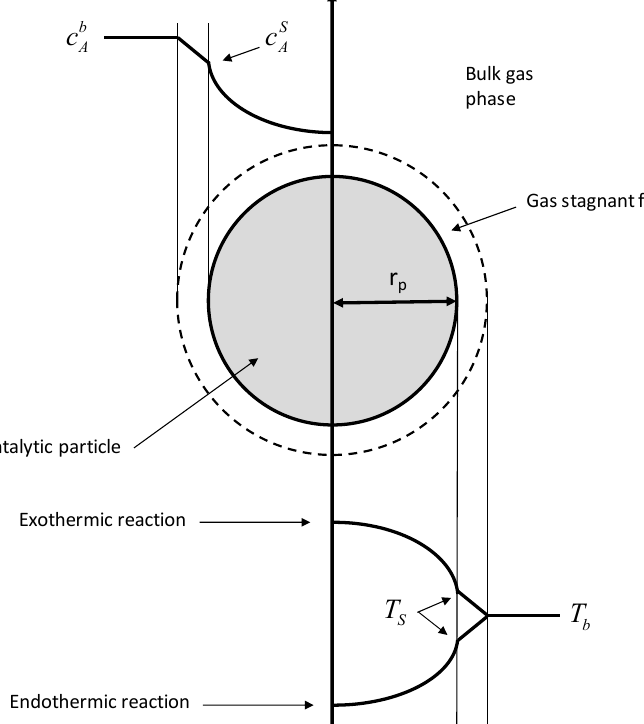
Figure 3. Profiles of concentration and temperature in a spherical catalytic particle.